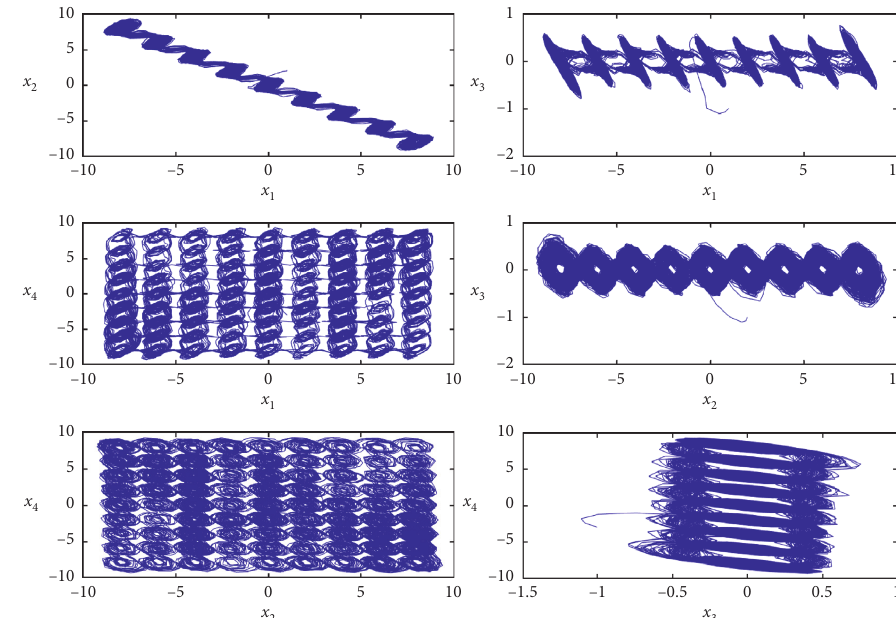
Figure 4: Multiscroll chaotic attractor of system (1) with M � 4and N � 4.